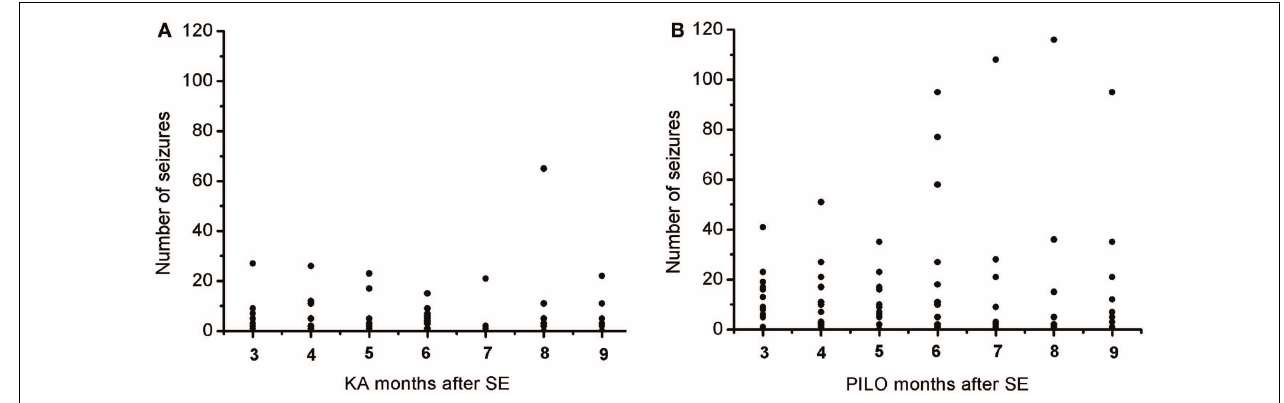
FIGURE 7 | Graphic representation of the monthly distribution of spontaneous recurrent seizures in rats treated with (A) kainic acid (KA) or (B) pilocarpine (PILO) over the 9months following status epilepticus (SE)